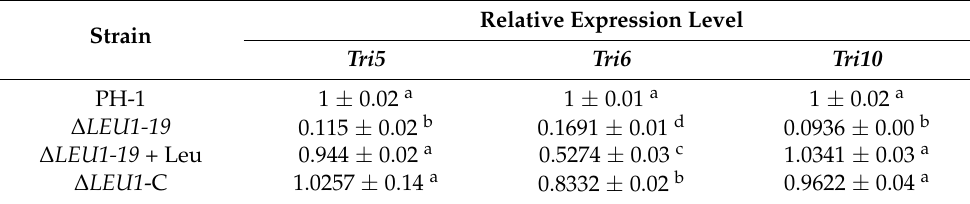
Expression levels of several genes at the level of transcription. The relative expression level of GAPDH gene was used as an internal control. The gene expression in PH-1 was set to 1.0. Different letters behind data for each treatment indicate significant difference at p < 0.05 by Duncan’s multiple range